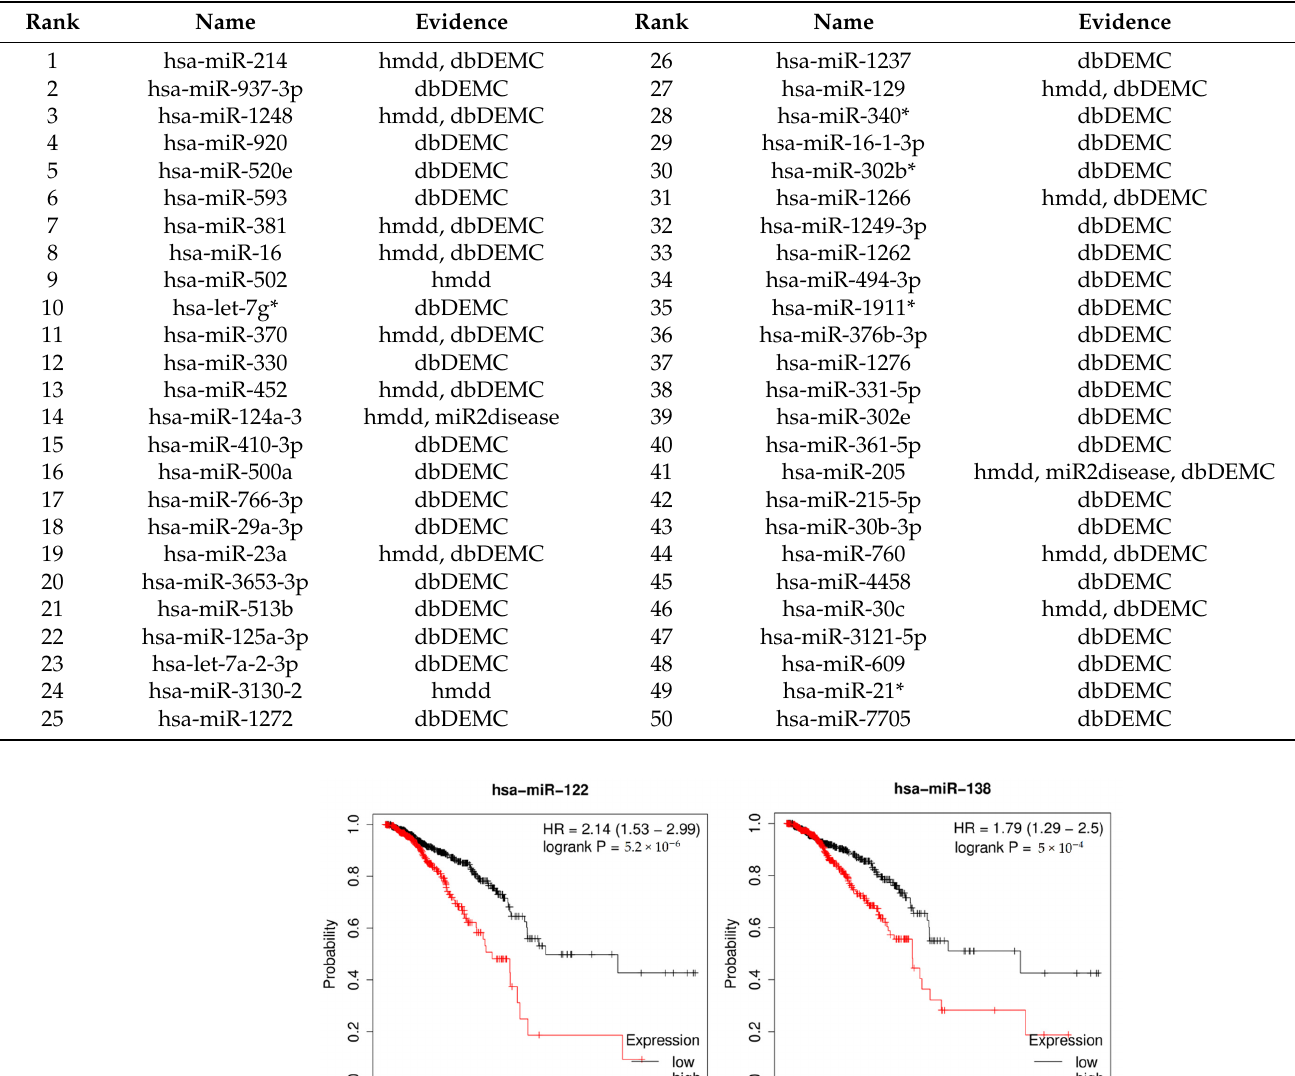
Table 6. Top 50 lung cancer-related miRNAs predicted by MDMF and their evidence. All miRNA candidates were proved to be related with lung cancer.